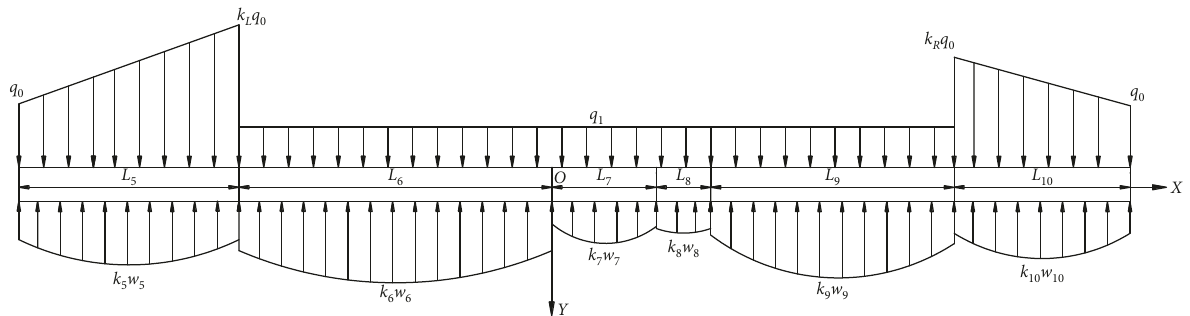
Figure 5: Mechanical model of mining the remaining upper